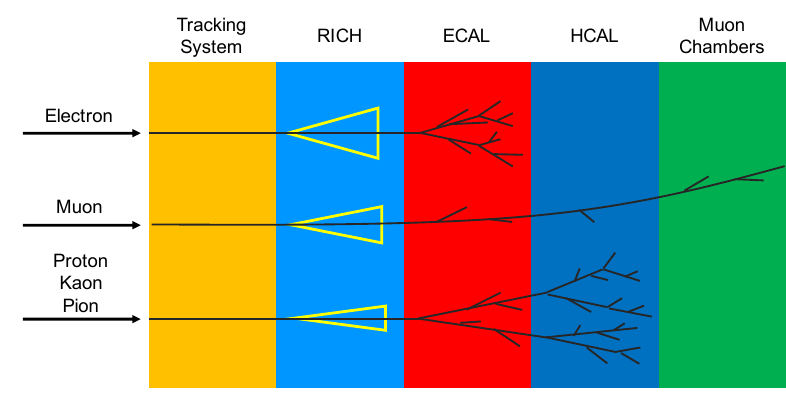
Figure 1. Illustration of di ↵ erent particle type responses in the LHCb